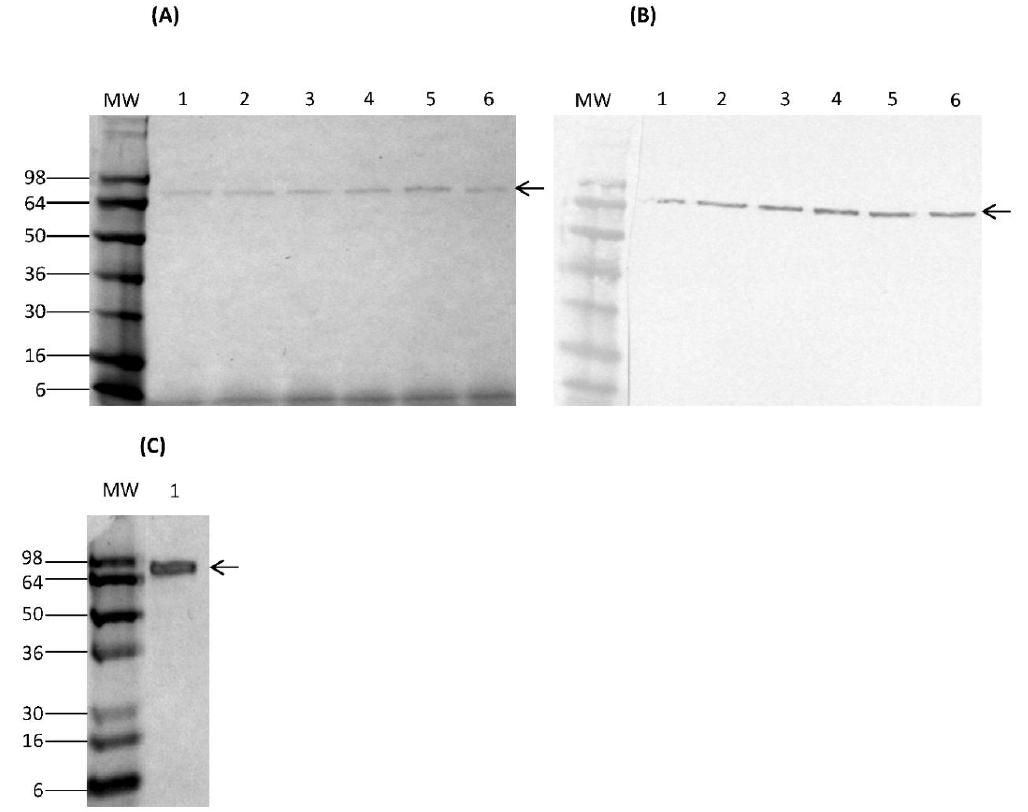
Figure 1. Time course of expression of K. lactis culture supernatant fractions containing secreted rCSA by ( A ) SDS-PAGE and ( B ) Western immunoblot analysis. Lane 1–6: galactose-induced culture supernatants from day 2–7. ( C ) SDS-PAGE analysis of purified nCSA. The arrows indicate the positions of both rCSA and nCSA at 69 kDa. MW: molecular weight marker SeeBlue ® Pre-Stained Protein Standard. MW: molecular weight marker; rCSA: recombinant chicken serum albumin; SDS-PAGE: sodium dodecyl sulphate gel electrophoresis; nCSA: natural chicken serum albumin.